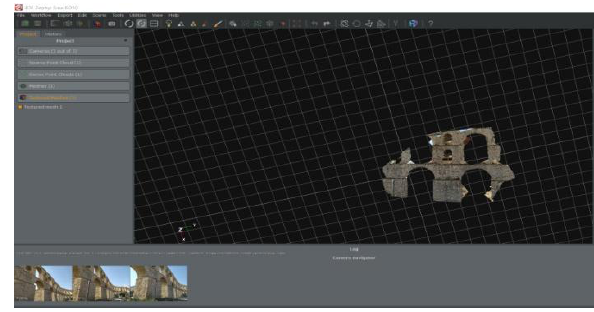
Figure 10. The Part of Behind in Aqueduct